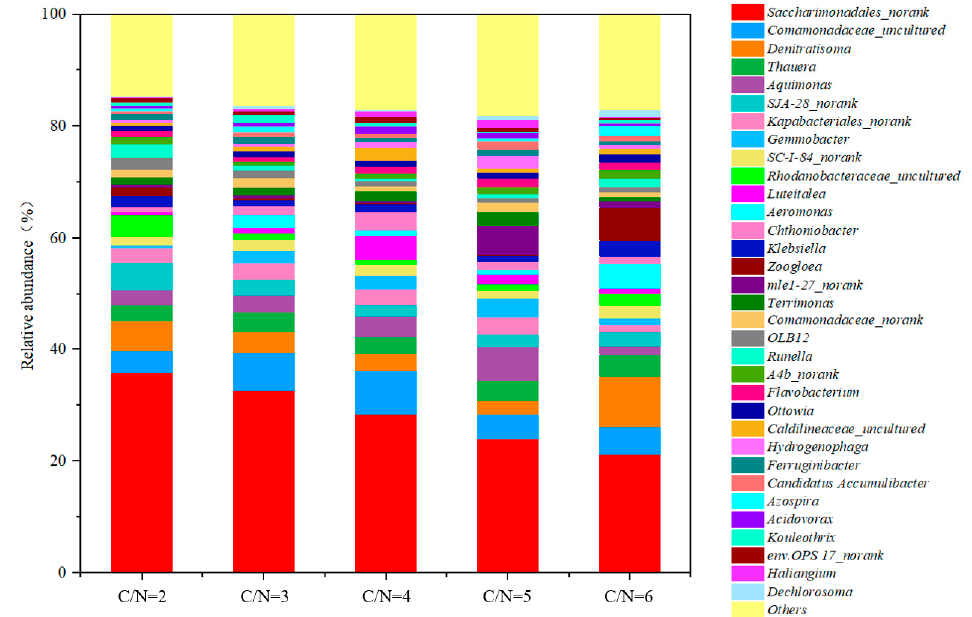
Figure 4. Microbial community structure of biofilm under different influent C/N (genus level).